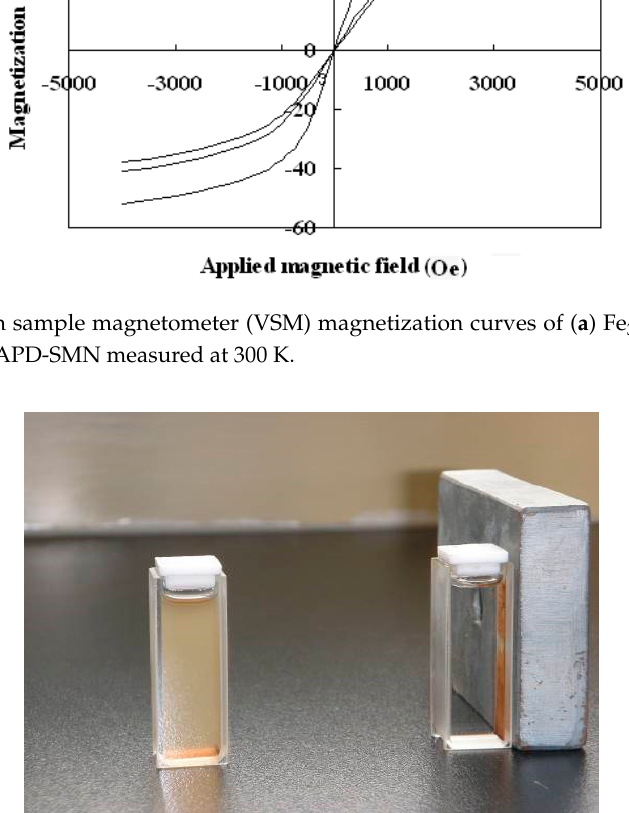
Figure 6. The dispersion and separation effect before and after using external magnetic field.